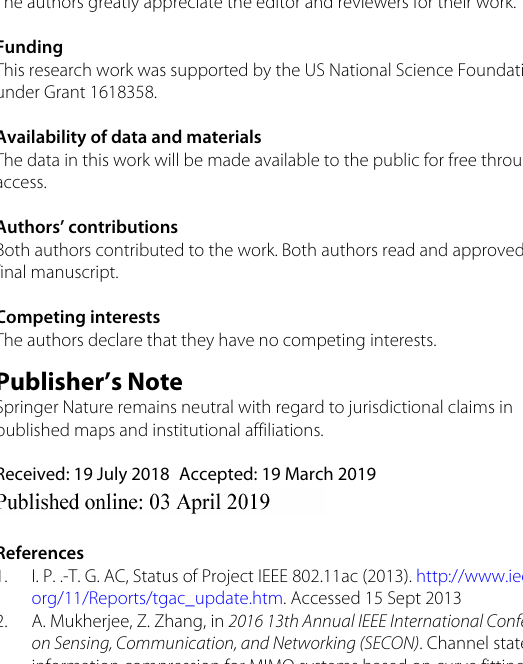
Abbreviations CSI: Channel state information; OFDM: Orthogonal frequency division multiplexing; MU-MIMO: Multi-user multiple-input-multiple-output;